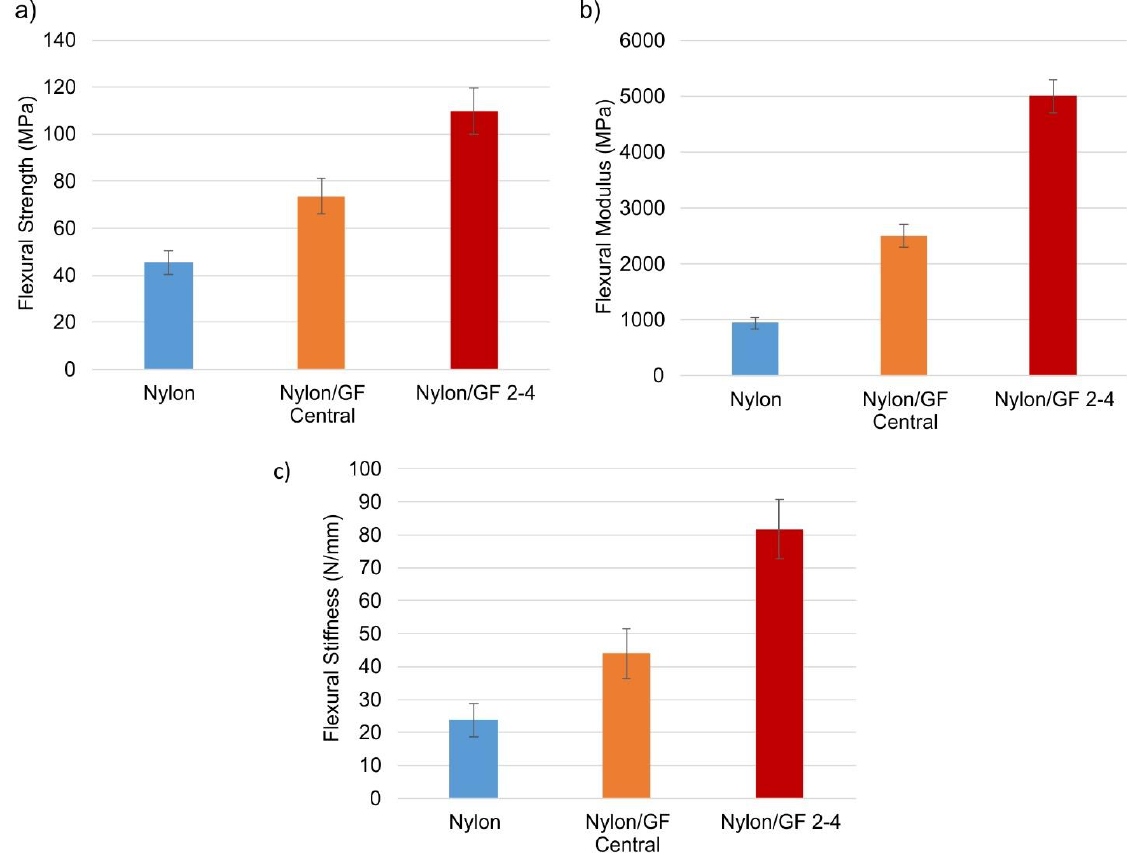
Figure 12. ( a ) Flexural strength, ( b ) flexural modulus and ( c ) flexural stiffness for each nylon structure reinforced with fiberglass in different positions.